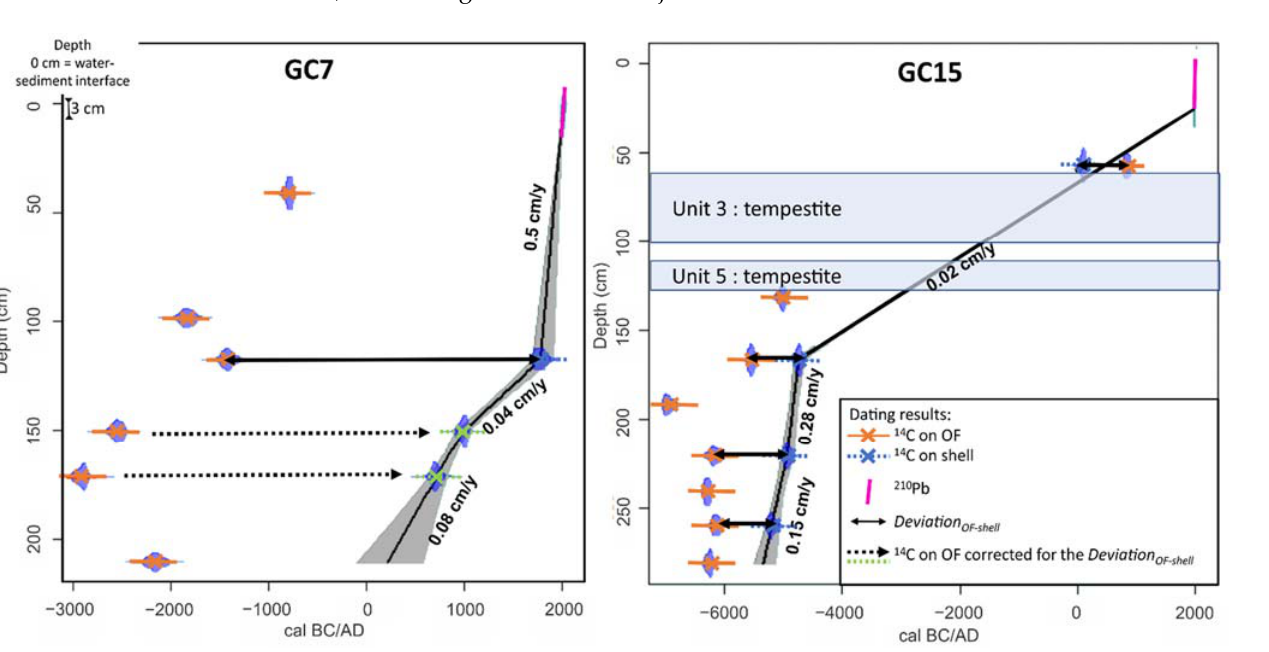
Figure 5. Age ‐ depth models of GC7 ( left ) and GC15 ( right ) cores calculated with the Software CLAM version 2.2 [35]. The black line corresponds to the age ‐ depth model (linear regression). The 95% confidence interval (2 σ ) is defined by the grey area around the age ‐ depth model. The ages taken into account in the model are the 210 Pb ages (fuchsia) and 14 C calibrated ages on shells (blue). For the GC7 age ‐ depth model, two ages were corrected for the Deviation OF ‐ shell (2950 ± 60 years): 150.5 and 171.5 cm depths (green). The dating result at 117.5 cm depth in GC7 is the only one made on a shell. The orange ages correspond to the results removed from the final age ‐ depth model (OF). The age reservoir effect (global and local) has been corrected for all measurements.